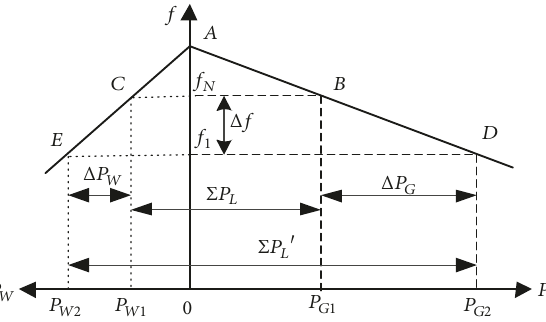
Figure 2: Frequency regulation characteristics of synchronous generator and DFIG-based wind turbine in parallel operation